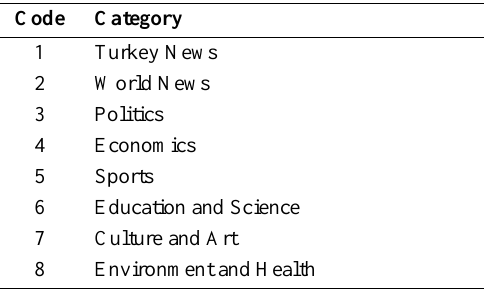
Table 3. News categories in data set